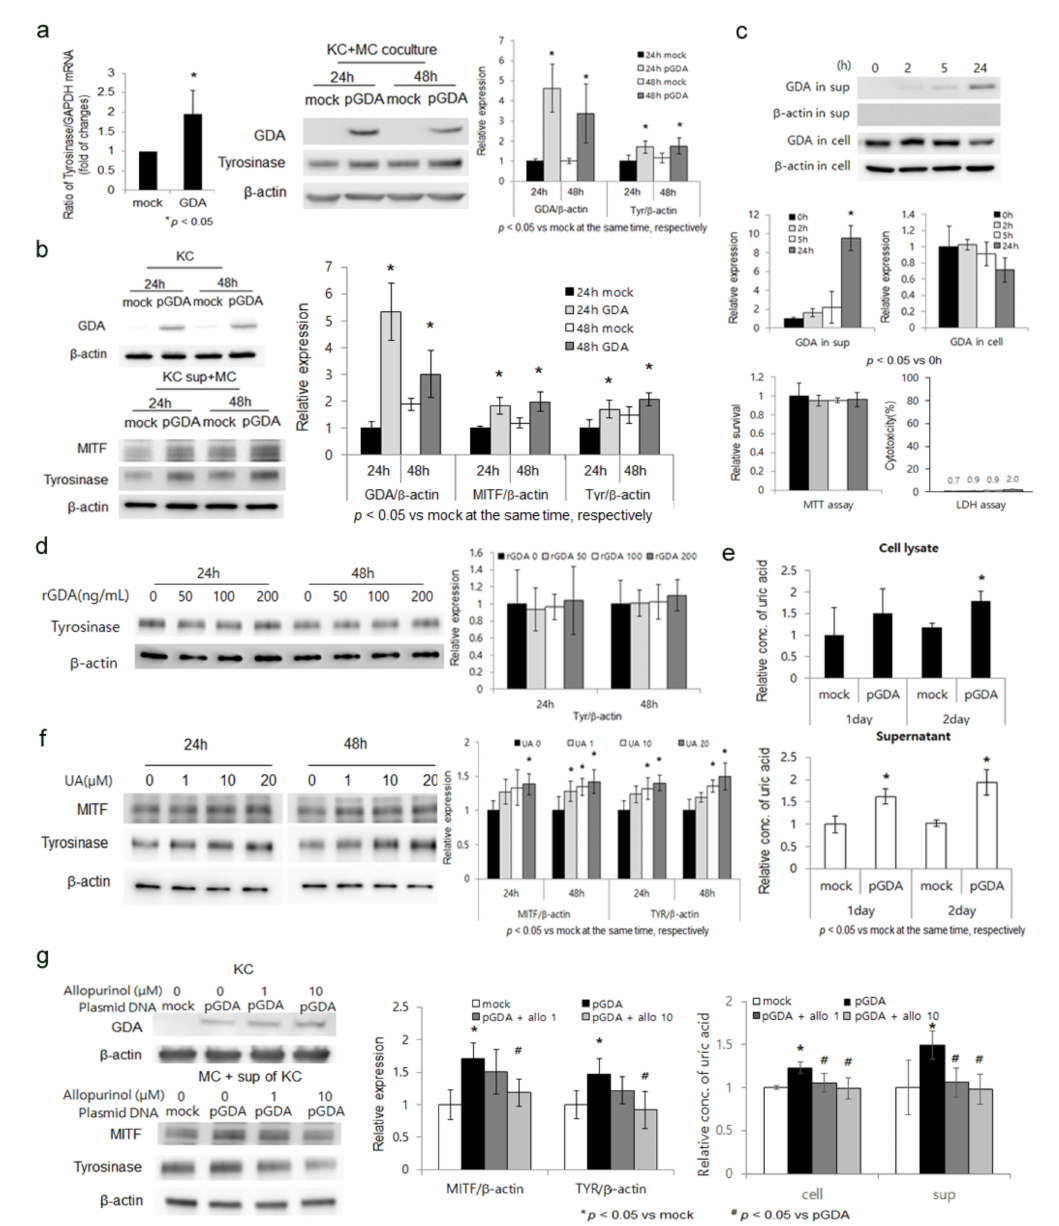
Figure 1. GDA upregulation in keratinocytes stimulates melanogenesis by releasing uric acid. ( a ) Real-time PCR and Western bot analyses for relative ratios of tyrosinase mRNA and protein levels, respectively, in primary cultured normal human skin melanocytes (MC) cocultured with GDA -overexpressing keratinocytes (KC). ( b ) Western blot analysis to determine relative ratios of tyrosinase and MITF protein levels in normal melanocytes treated with supernatants from GDA - overexpressing keratinocytes. ( c ) Western blot analysis for relative ratios of GDA protein levels in culture supernatants and GDA -overexpressing keratinocytes, whose viability and cytotoxicity were measured by MTT and LDH assays, respectively. ( d ) Western blot analysis for relative ratios of tyrosinase in normal melanocytes treated with recombinant GDA (rGDA). ( e ) Uric acid assay for measuring concentrations of uric acid in cell lysates and culture supernatants from keratinocytes after GDA overexpression for 2 days. ( f ) Western blot analysis for relative ratios of tyrosinase and MITF proteins in normal melanocytes treated with various concentrations of uric acid (UA). ( g ) Western blot analysis for relative ratios of tyrosinase and MITF proteins in normal melanocytes treated with supernatants from GDA -overexpressing keratinocytes cultured in the presence of various concentrations of allopurinol along with uric acid concentrations. β -Actin and GAPDH were used as internal controls for Western blot analysis and real-time PCR, respectively. Data represent means ± SD of four independent